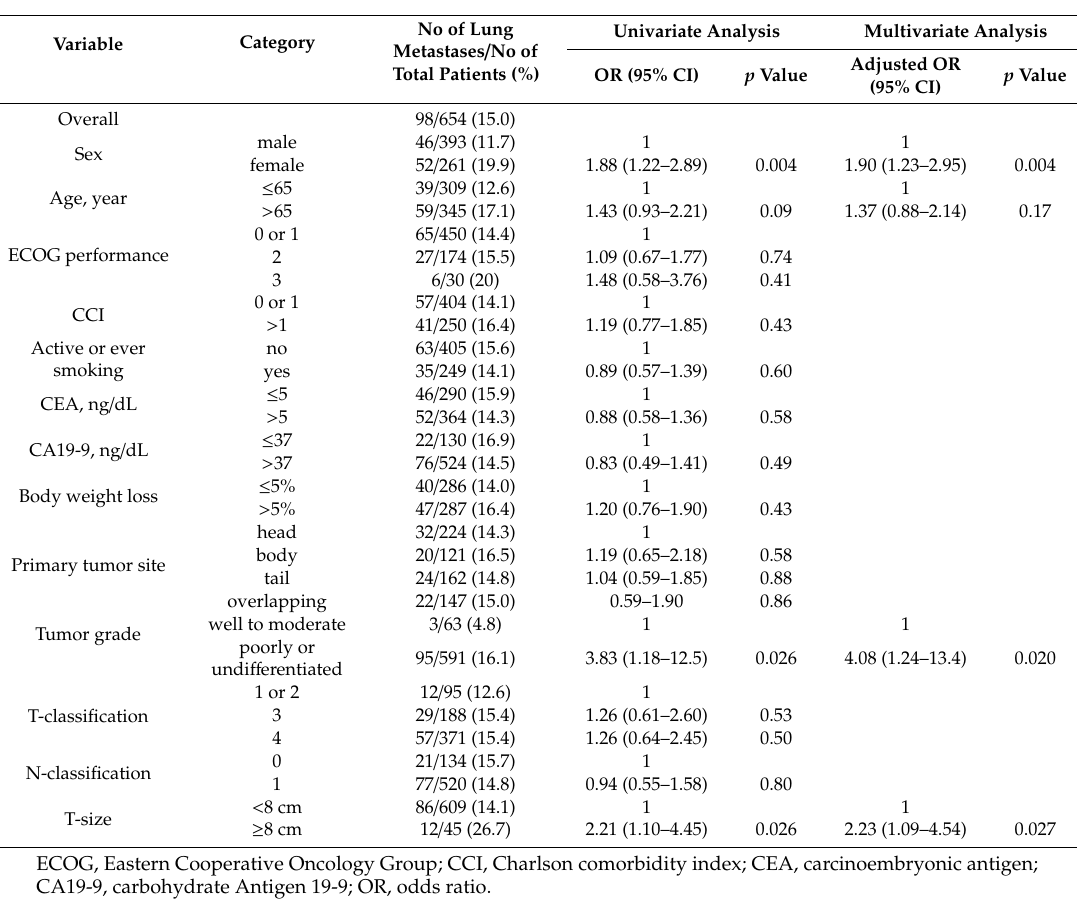
Table 2. Univariate and multivariate analysis for presence with lung metastases.